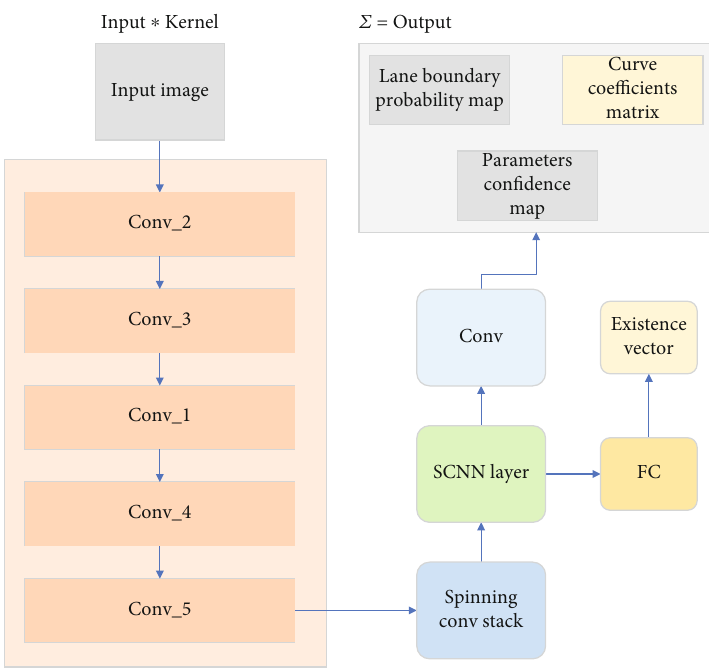
Figure 1: The traditional two-dimensional convolution